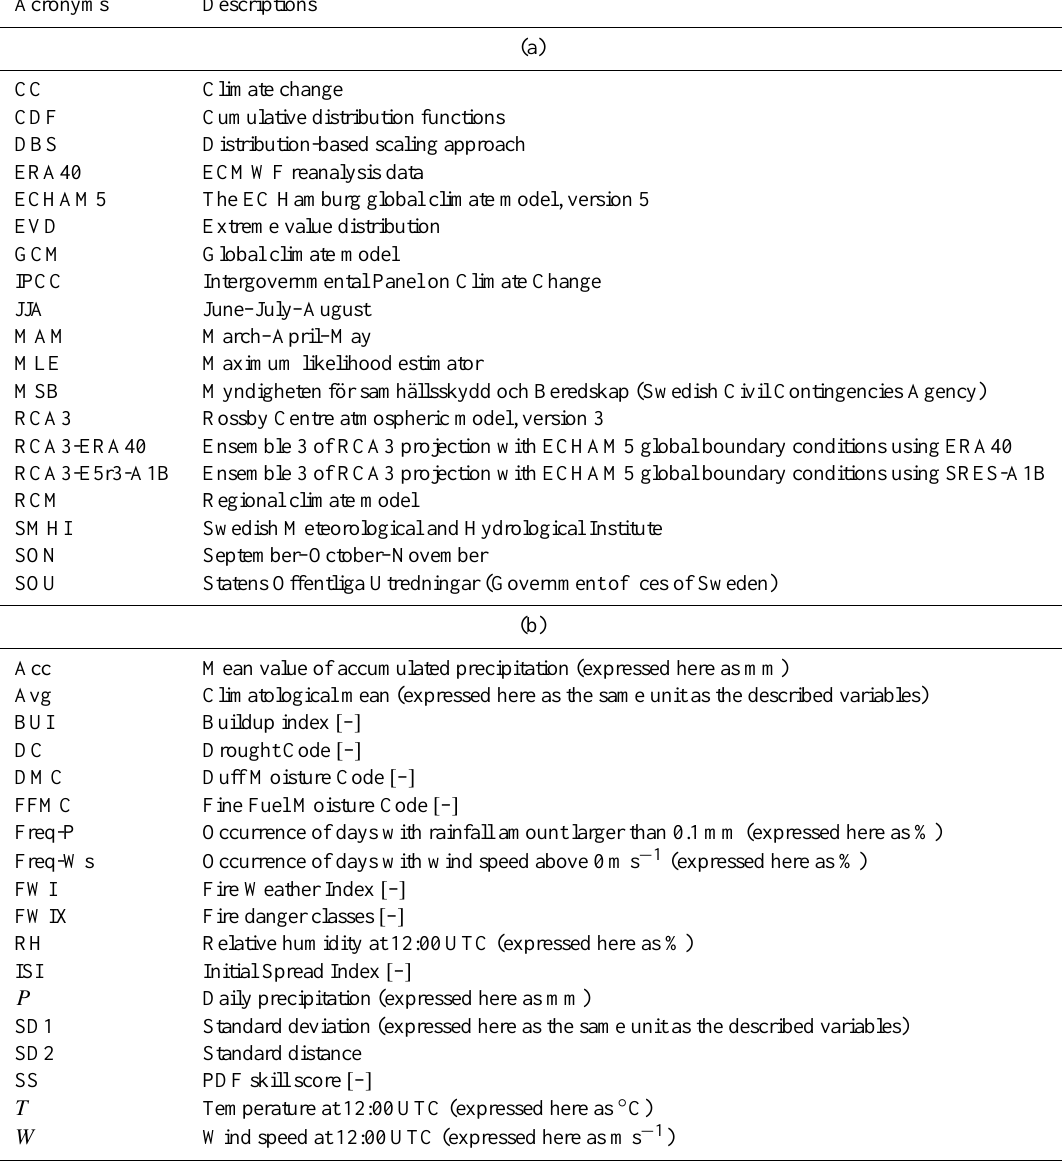
Table A1. (a) List of acronyms and (b) list of